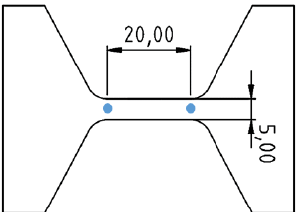
Fig. 1. Specimen geometry for material characterization. The blue dots mark the positions of virtual extensometers for the displacement measurement.